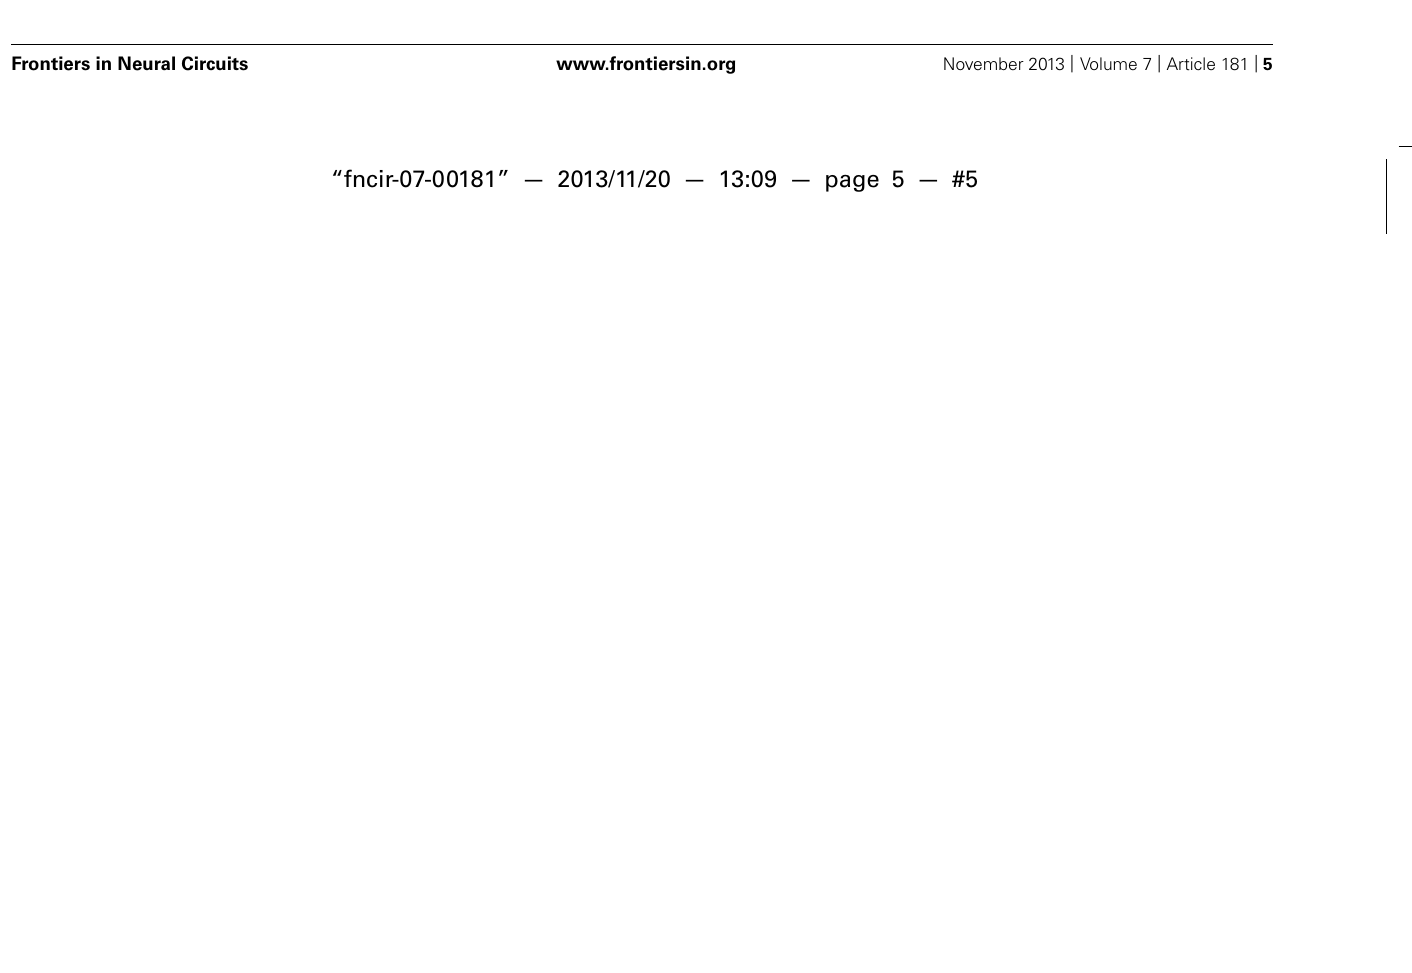
grid patterns (second row) and appear to be organized by local theta oscillations (third row) as spike activity advances from late to early phases of the theta cycle as the animal passes through each grid vertex. Averaged across the entire 16 min session, the spiking of the SDWs on entry into the periphery of each field tends to occur on one phase, while the firing in the central part of each field tends to be earlier by about 180 ◦ . The firing pattern the first putative axon in 5a resembles a place field but is phase locked between 120 and 240 ◦ . The bottom row shows the autocorrelation for each putative axon and is indicative of significant theta modulation in their firing